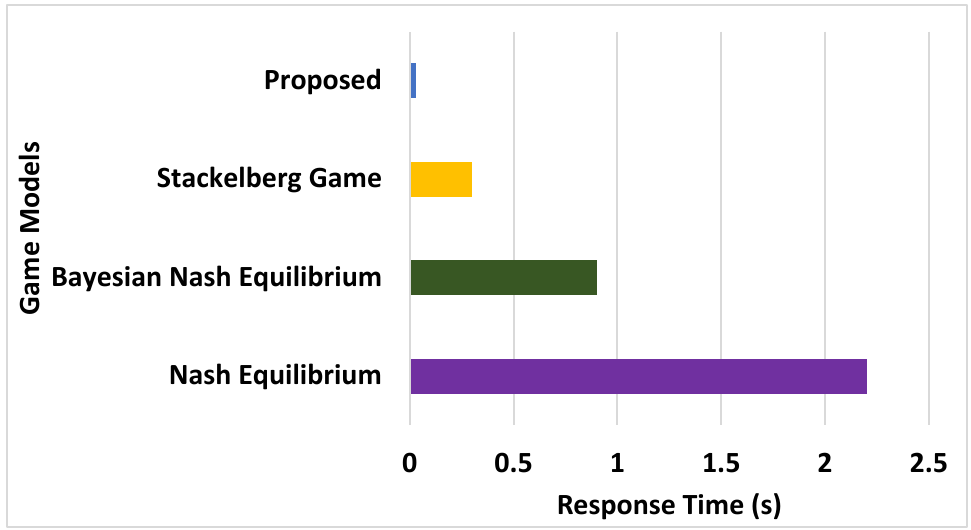
Figure 9. Comparative analysis of response time.